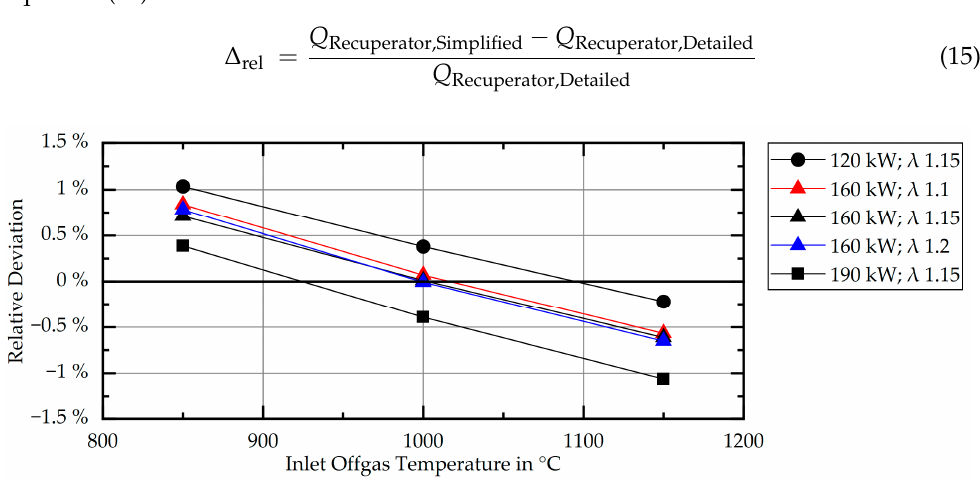
Figure 18. Relative deviation of heat transfer in the simplified model from the heat transfer in the detailed model.